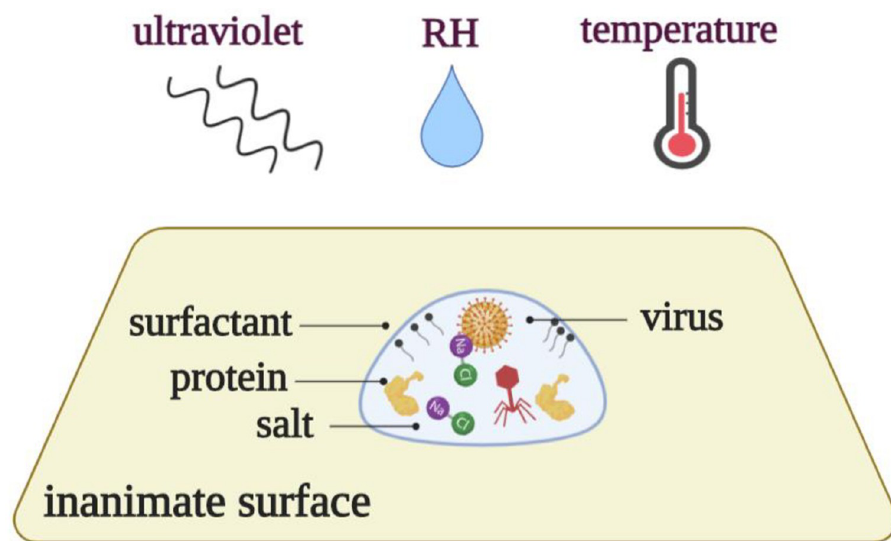
Fig 1. Factors that affect the survival of viruses in stationary droplets on